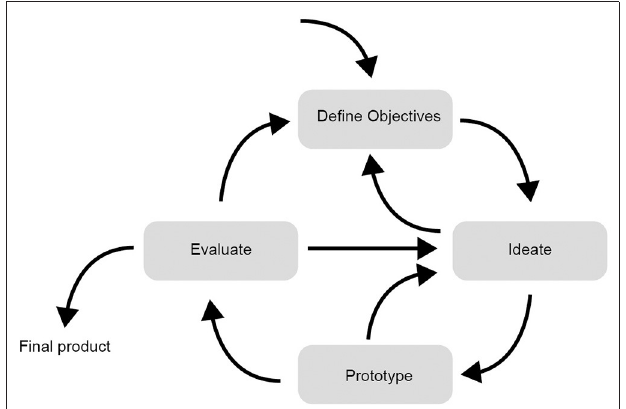
FIGURE 1 | An iterative interaction design